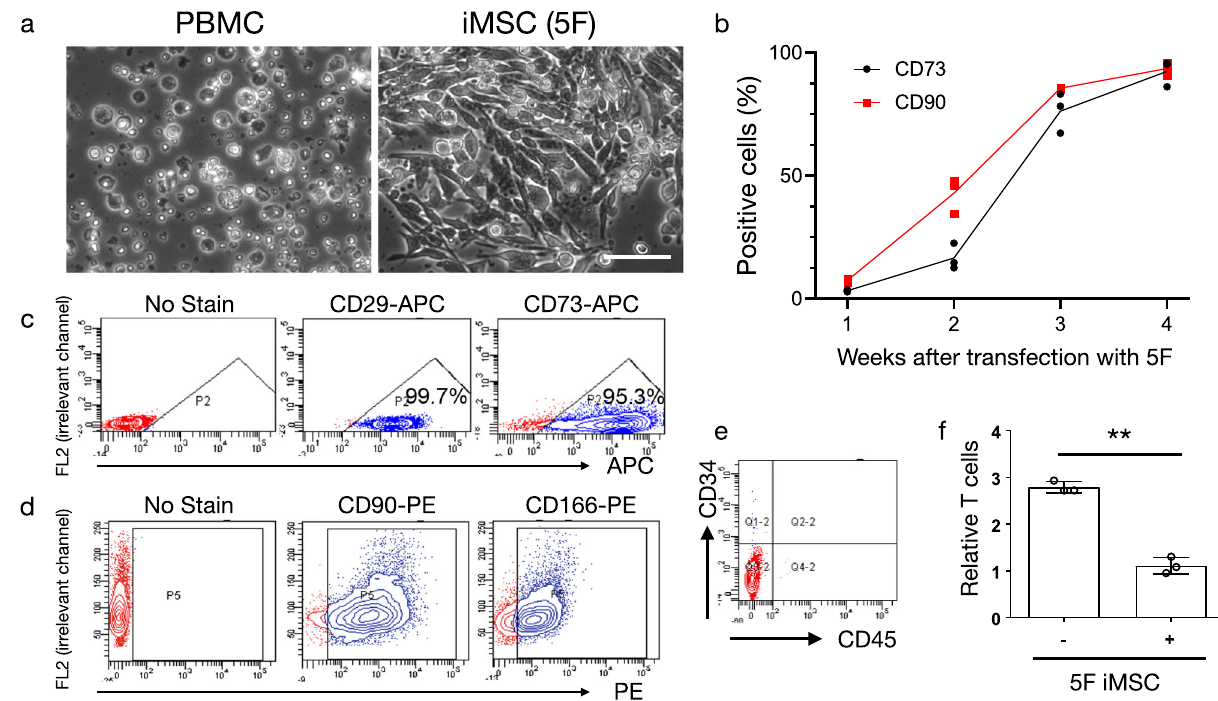
Fig. 2 Direct reprogramming of human PBMCs into iMSCs using fi ve episomal vectors expressing OCT4, BCL-XL, MYC, KLF4, and SOX9 (5F). a Representative images of human PBMCs and iMSCs 14 days after reprogramming with fi ve factors (5F). Scale bar represents 100 μ m. b Changes in the percentage of cells expressing the MSC markers CD73 and CD90 as measured by fl ow cytometry of 5F-transfected PBMCs over time. c , d Flow cytometry plots of typical MSC marker expression (CD29, CD73, CD90, CD166) at 4 weeks after reprogramming. n = 3 biologically independent samples for time point. e Blood cell markers (CD45 and CD34) were assessed 4 weeks after transfection of reprogramming factors. f iMSCs signi fi cantly inhibited T-cell proliferation after 3 days of co-culture with PBMCs. ** P = 0.0007. Error bars indicate standard deviation. n = 3 biologically independent samples for each